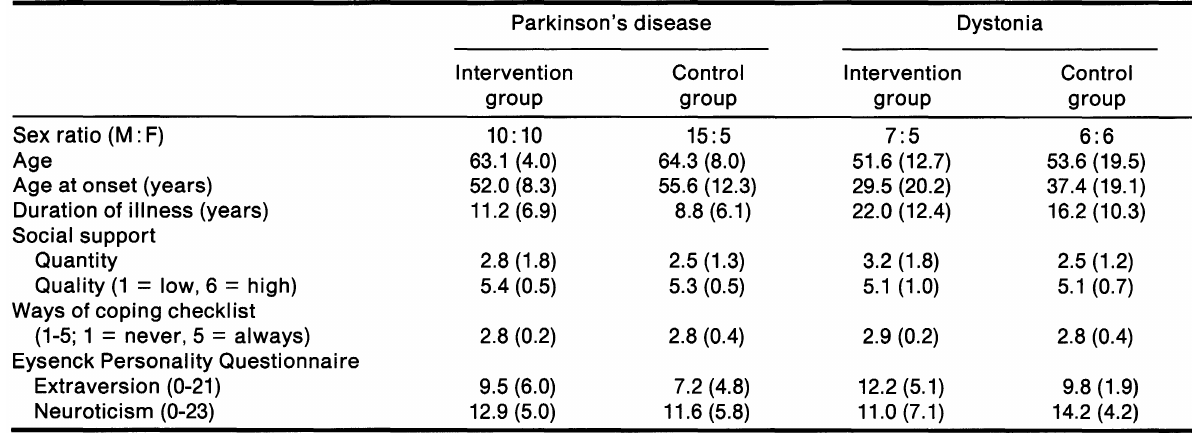
TABLE I. Demographic variables and the mean scores (and S.D.) on the putative intervening or mediating variables of the patients with Parkinson's disease or dystonia allocated to the "intervention" or "control" groups